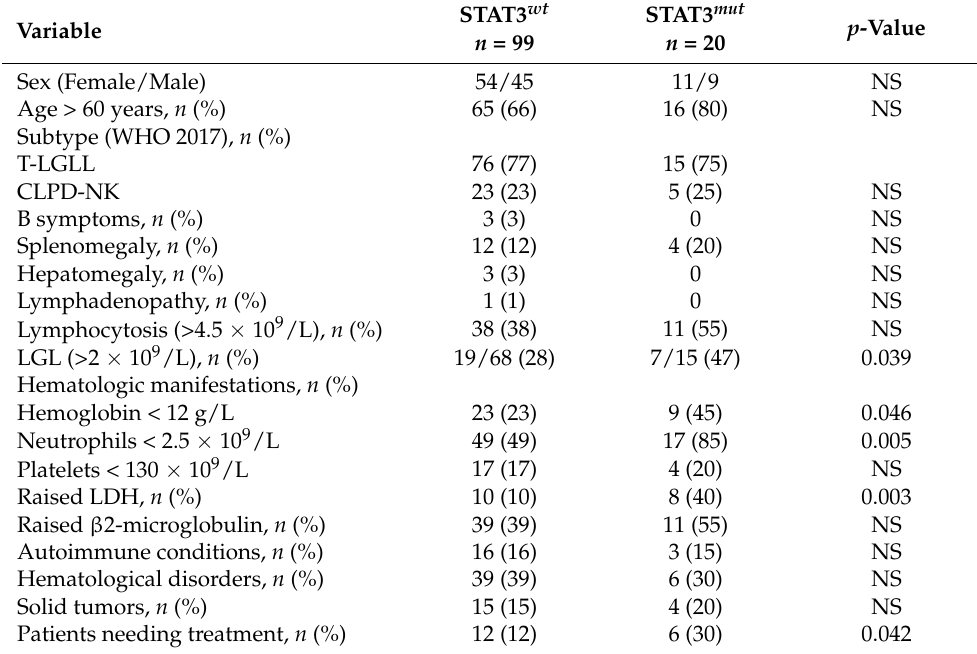
Table 4. Clinicobiological characteristics according to the mutational status of STAT3